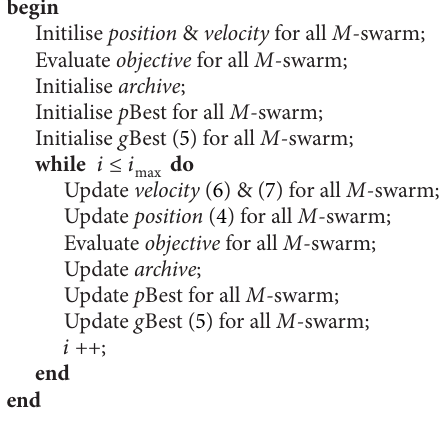
Algorithm 2: The VEPSO algorithm.